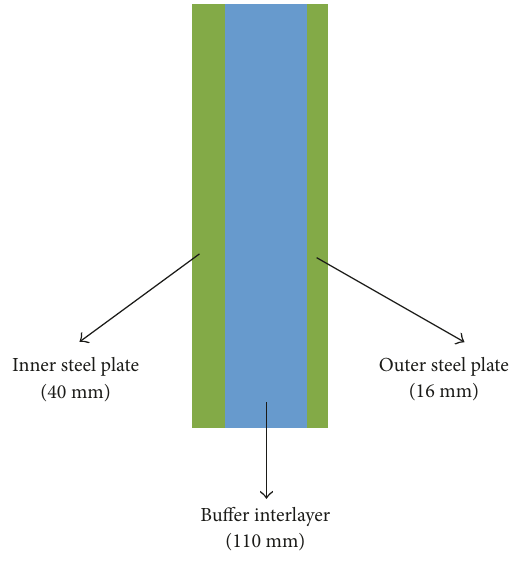
Figure 1: Schematic diagram for the special “steel plate–buffer interlayer–steel plate”